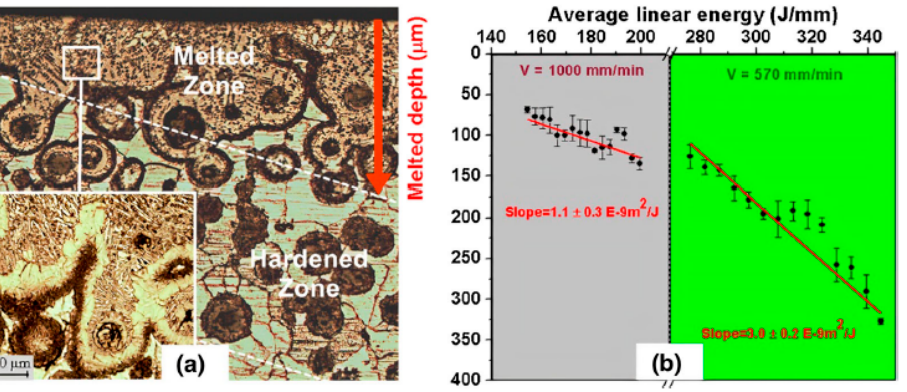
Figure 16. ( a ) Melted zone (MZ) and hardened zone (HZ) of laser surface-modified microstructure of DI; ( b ) melted depth as a function of the average linear energy of the laser (Reprinted with permission from ref. [69]. 2021 Springer Nature BV).